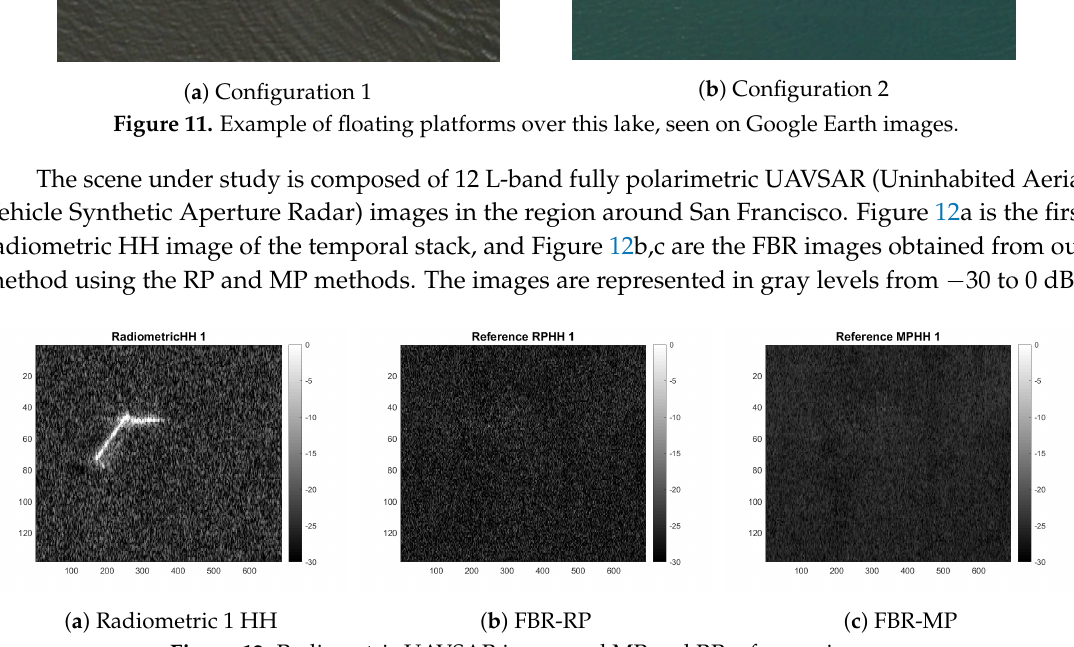
Figure 12. Radiometric UAVSAR image and MP and RP reference